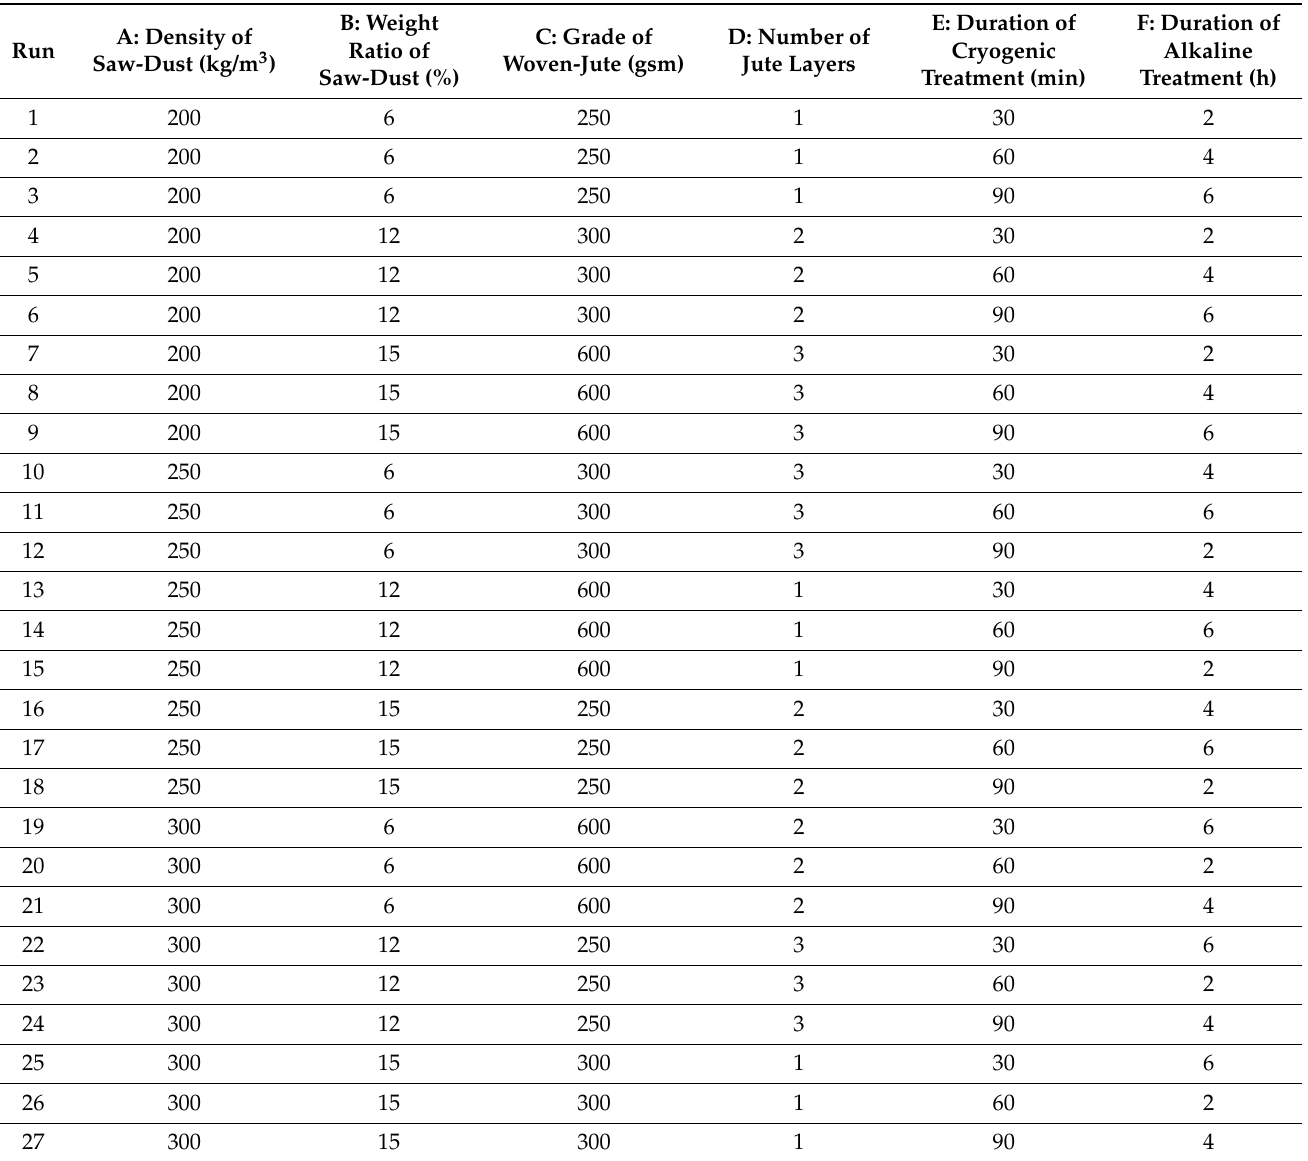
Table 2. Experimental design matrix based on L 27 orthogonal